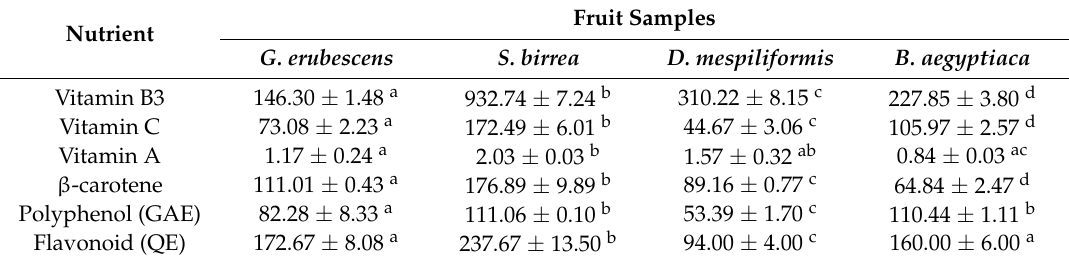
Table 4. Vitamin and antioxidant compositions (mg/100 g) of four underutilized forest fruits.